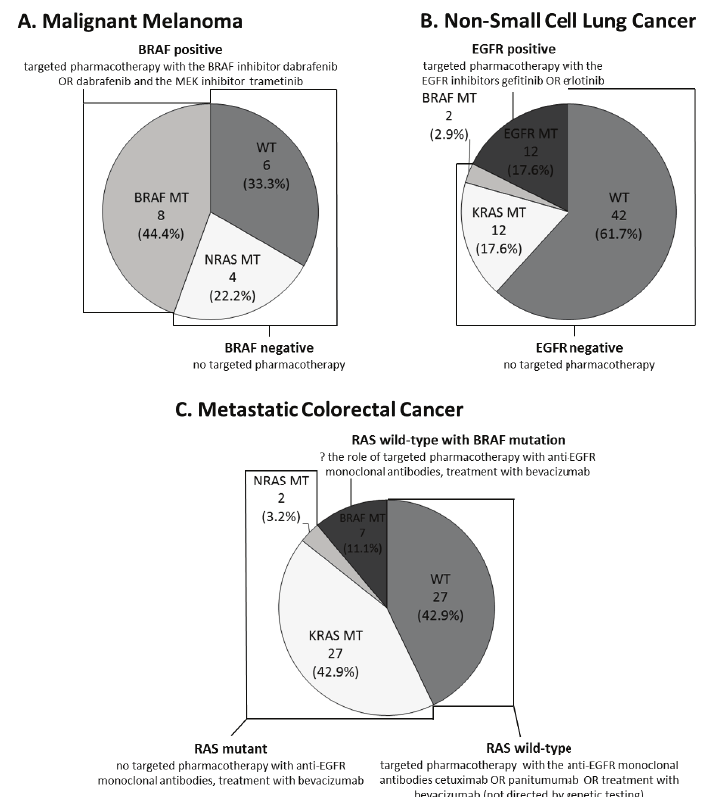
Figure 1. OncoFOCUS™+ KIT results, molecular cancer classifications, and the 2015 NCCN guideline recommendations for targeted